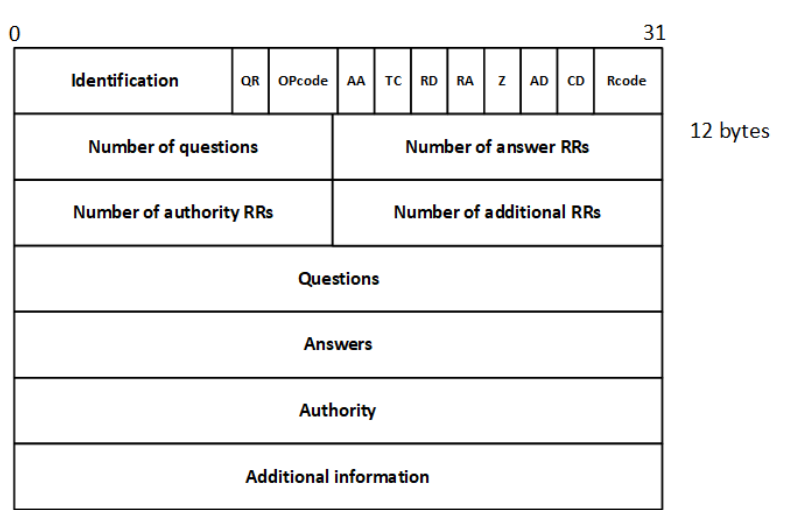
Figure 2. DNS message